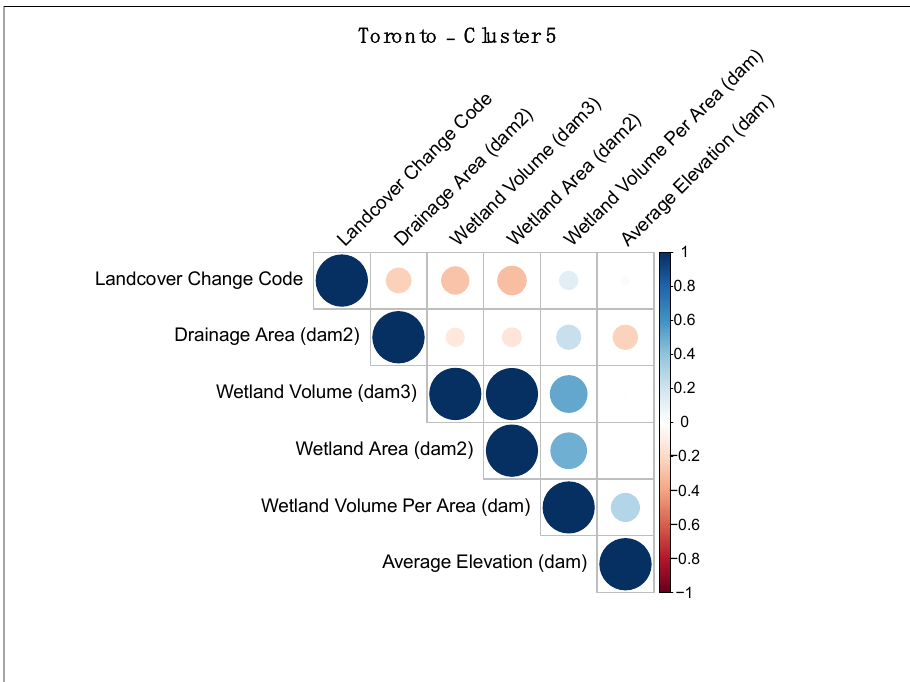
Figure 6. Toronto cluster 5 correlation matrix. The spatial distribution of the city of Toronto wetland areas by SOM cluster is shown in Figure 7. Wetland areas in cluster 1 tend to be densely concentrated along watercourses throughout Toronto; however, this cluster does contain several wetland areas that are geographically isolated and removed from the urban watercourses. Wetland areas in cluster 2 are geographically dispersed but are all located along the Humber River and Don River watercourses throughout Toronto. Wetland areas in cluster 3 are located both along watercourses throughout Toronto, as well as in geographically isolated areas, removed from the urban watercourses. Wetland areas in cluster 4 are geographically dispersed and are located on the Humber River, Rouge River, and Highland Creek watercourses, with a single, geographically isolated wetland area removed from the urban watercourses, located near the city’s centre. Wetland areas in cluster 5 are somewhat geographically dispersed but are all located along the Humber River, Don River, Rouge River, and Highland Creek watercourses throughout Toronto. There is some dense clustering of wetlands along the northern Don River, southern Rouge River, and along Highland Creek. Broadly, although clusters 4 and 5 contain the lowest numbers of wetland polygons, these wetlands tend to be much larger both in area in volume, compared to wetlands in clusters 1, 2, and